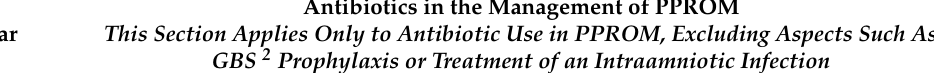
Table 2. Comparison of recommendations of selected scientific societies regarding antibiotic therapy in PPROM 1